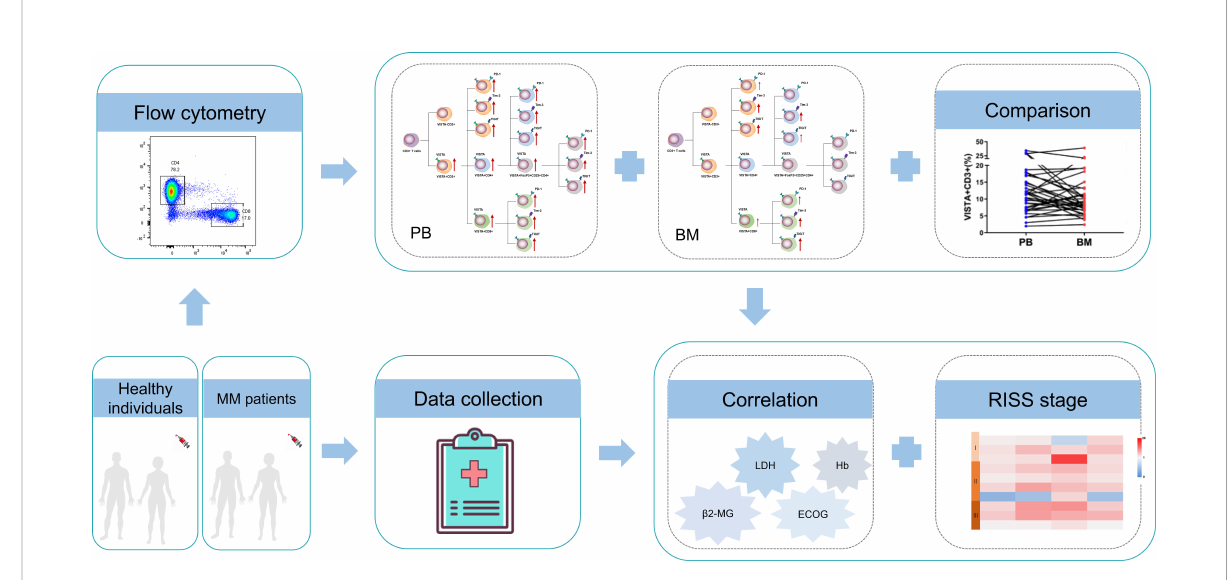
FIGURE 5 Study schematics and overview of the alterations of VISTA, PD-1, Tim-1, and TIGIT and T cell phenotypes in patients with